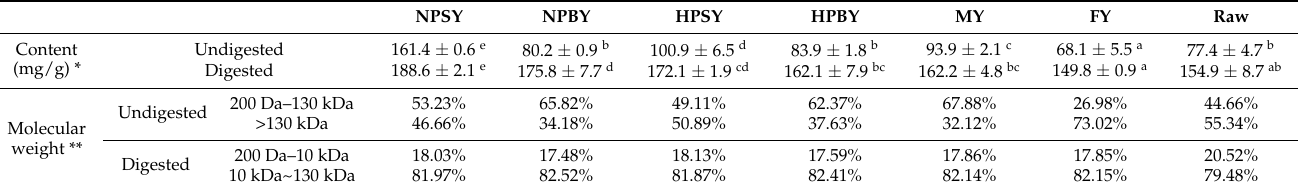
Table 1. The content and molecular weight of water-soluble yam